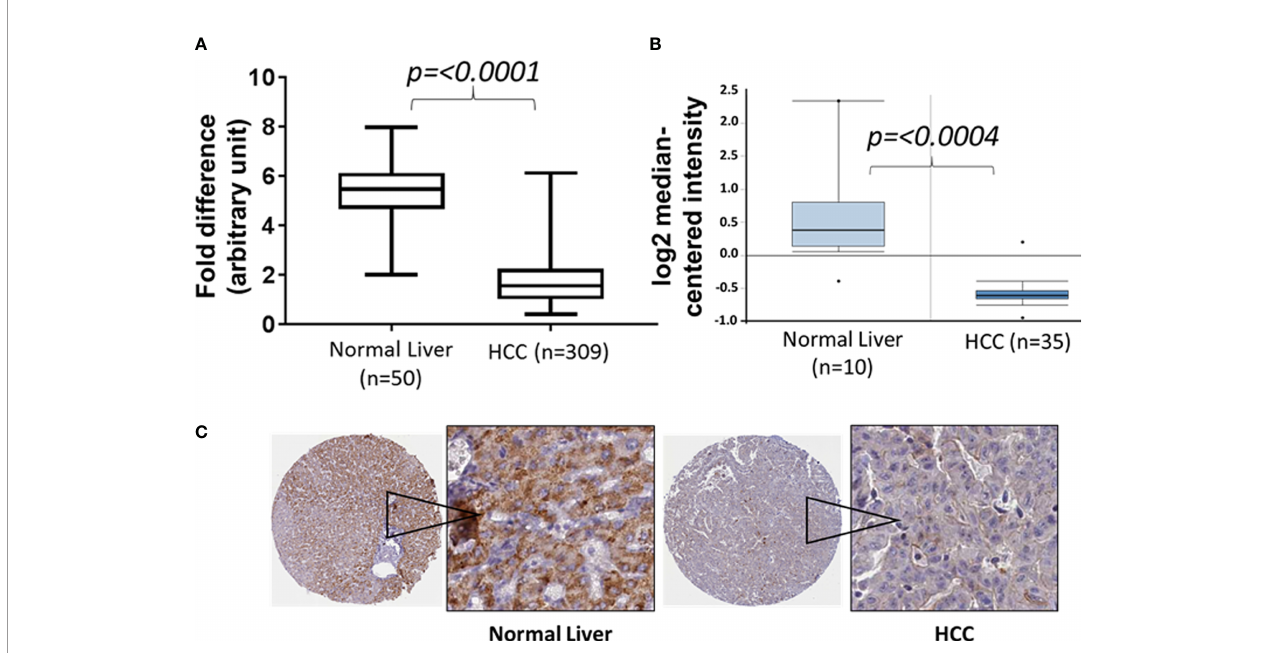
FIGURE 1 | Box and Whisker plots of CCL23 transcript expression levels from two different data sets ( A : TCGA liver cancer and B : Oncomine) and (C) the expression of CCL23 protein by immunohistochemistry data sets from the Human Protein Atlas (proteinatlas.org) in the normal liver and hepatocellular carcinoma (HCC). The expression level of CCL23 is signi fi cantly lower in HCC as compared to the normal